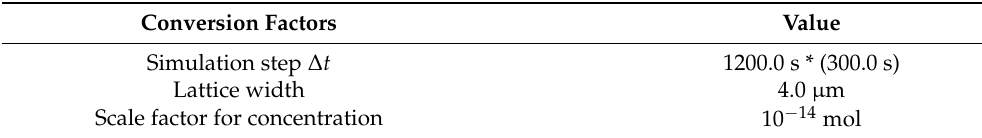
Table A2. Sego et al.’s conversion factors. We changed the simulation step time length from Sego’s simulation [24], going from 1200 s to 300 s. We have marked it with an asterix and included our value in parenthesis.